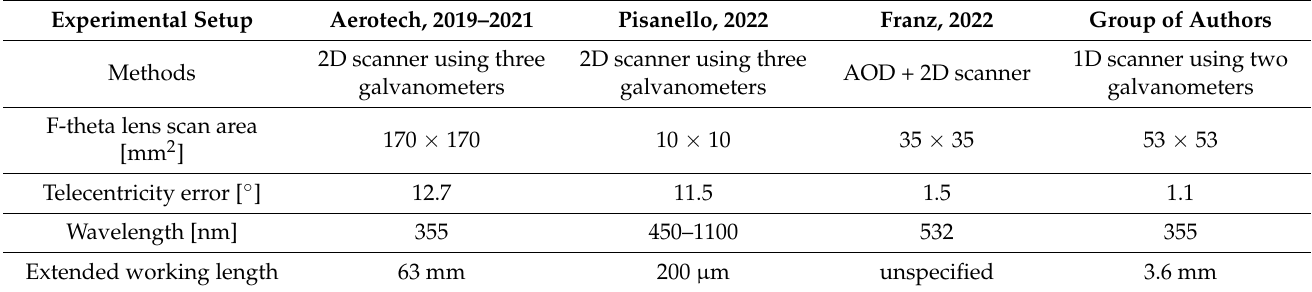
Table 2. Comparison results of various experimental